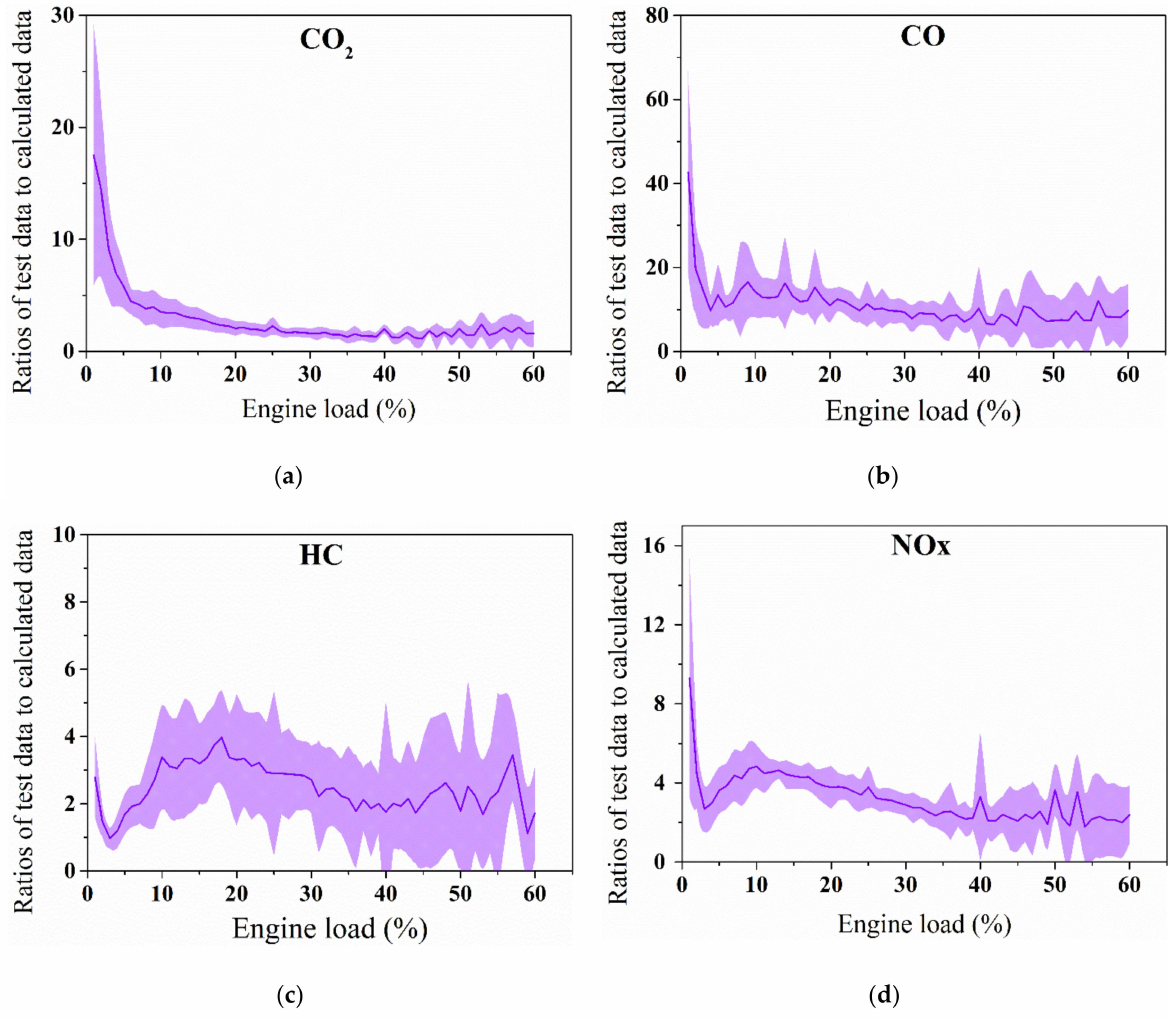
Figure 3. Ratios of the test data to calculated data of ( a ) CO 2 , ( b ) CO, ( c ) HC, and ( d ) NOx under different engine loads from typical inland ships. The shadings denote the 95% confidence intervals of the mean